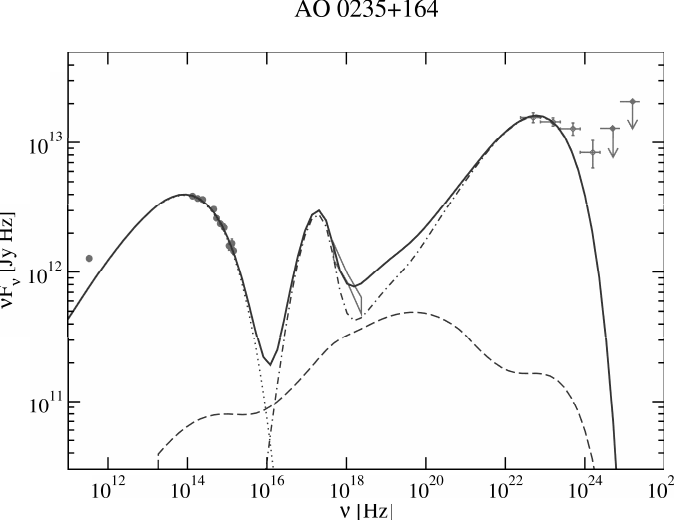
Figure 2. Fit to the SED of the low-frequency-peaked BL Lac object (LBL) AO 0235+164 (data from [23]), with η 1 = 225 and α = 3. Note that the soft X-ray excess (Big Blue Bump) is reproduced by the bulk Compton emission of the thermal electron population. From [11].